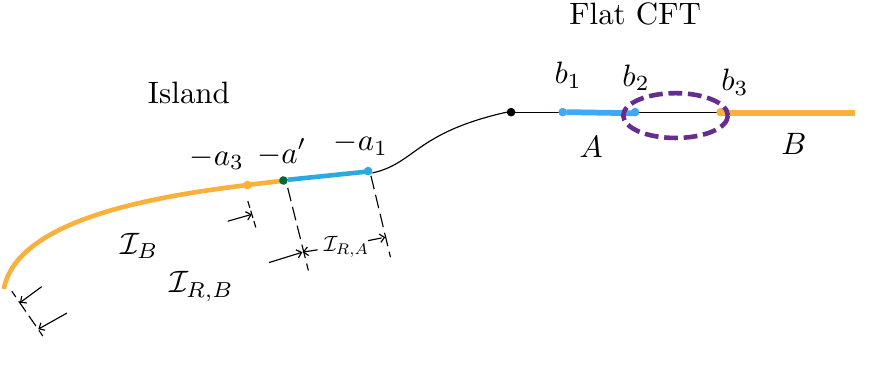
log 2) . Every curve corresponds 3